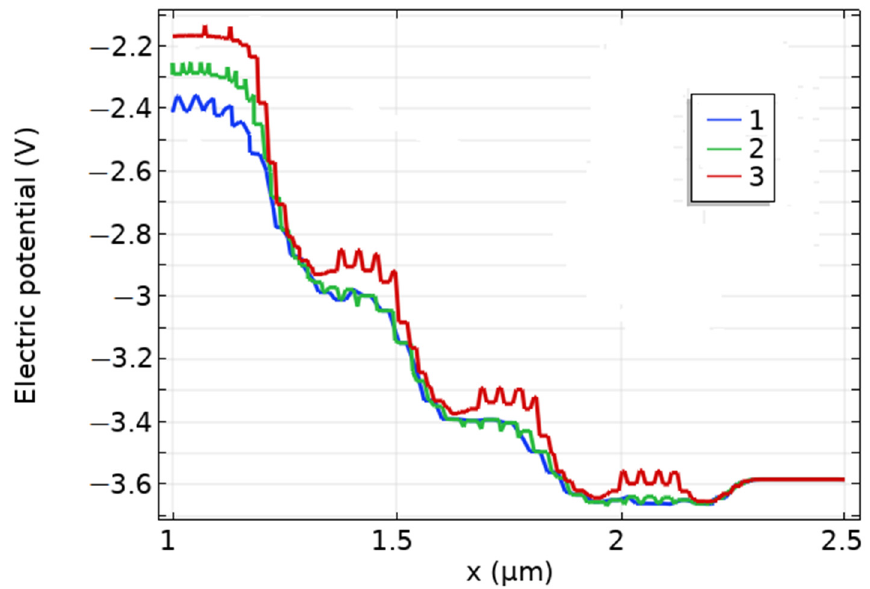
Figure 7. Electric potential distribution. Different cutlines: ( 1 ) Y = 0.65 μ m , (2 ) Y = 0.665 μ m, ( 3 ) Y = 0.685 μ m (located closely to the surface Y = 0.700 μ m). GaAs, p -type, p = 10 12 cm − 3 . Three surface charge segments = 3. U ct = 0.5 V, U an = 1 V, U g = 3 V. Surface charge density ρ = 10 − 3 C · m − 2